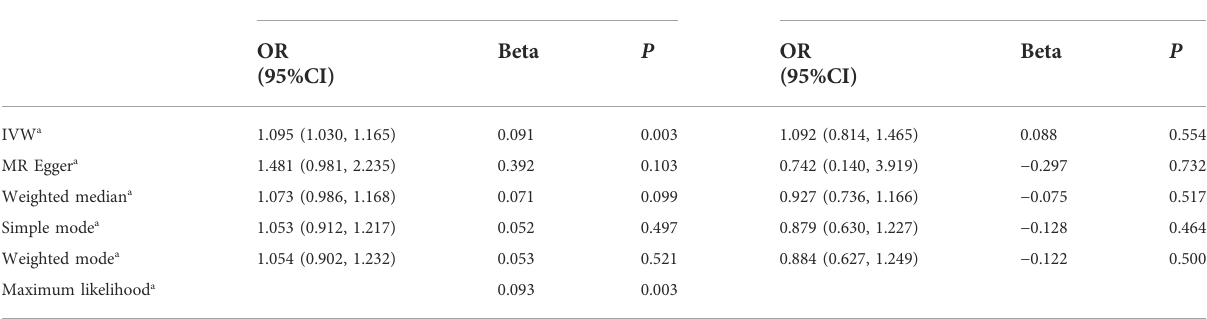
TABLE 3 BPH & BLCA: Bidirectional MR